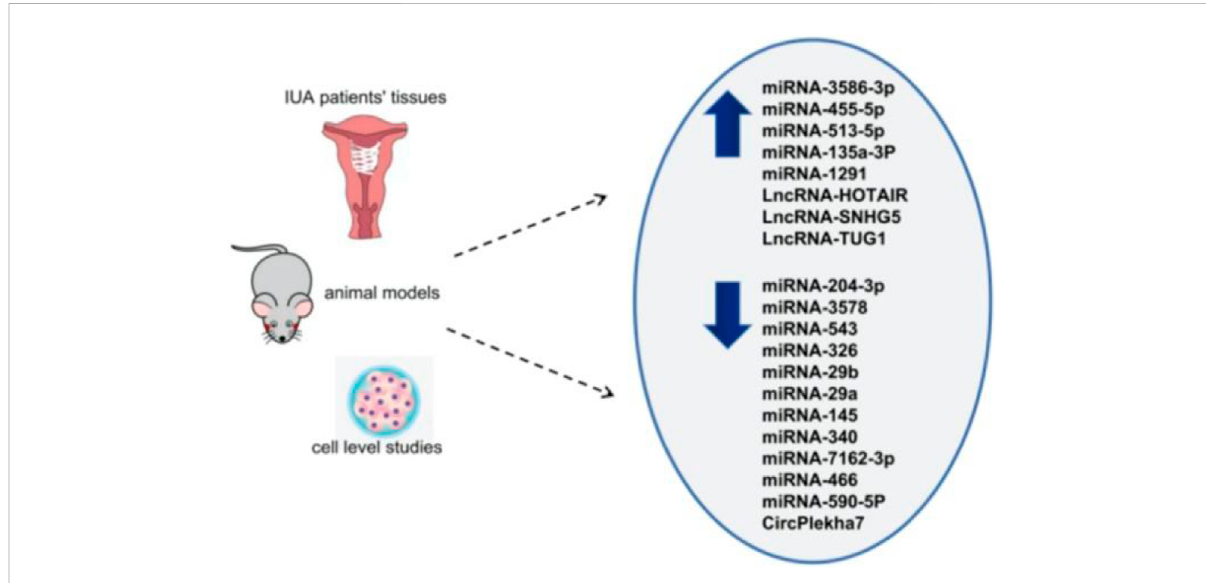
FIGURE 1 Differential expression of ncRNAs in IUA (upward arrow indicates high expression, downward arrow indicates low